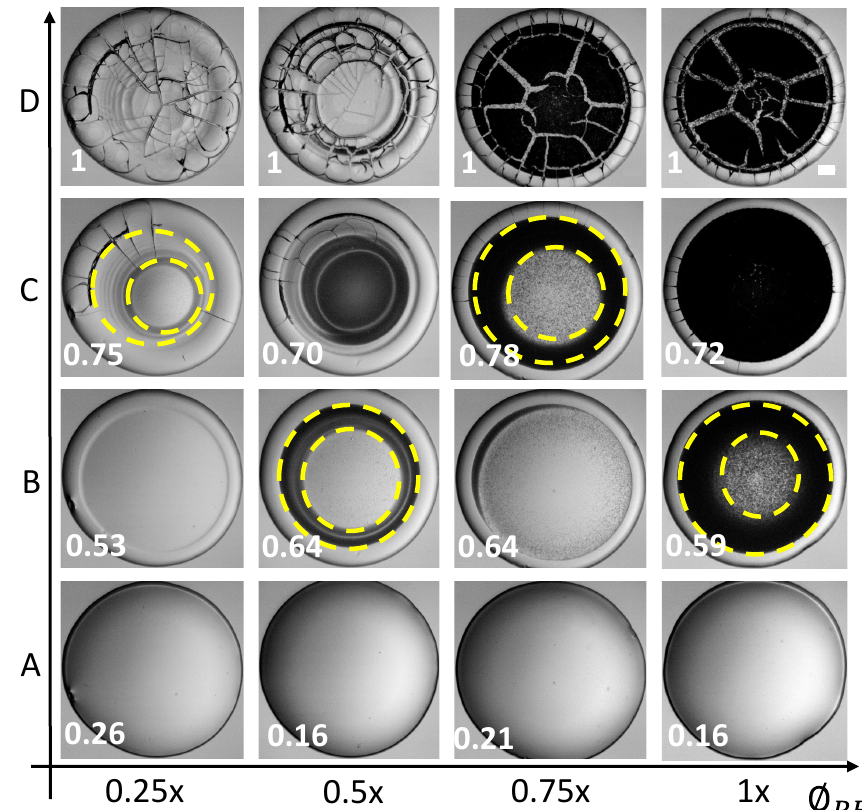
Figure 5. The time evolution of lysozyme drops ( φ Lys = 9 wt%) at various initial concentrations of salts in PBS ( φ PBS ) during the drying process is displayed in ( A – D ). The instantaneous time is divided by the total drying time ( t d ) to calculate the timestamps, as shown in the bottom left of each image. The white rectangle represents a scale bar of 0.15 mm length in the top